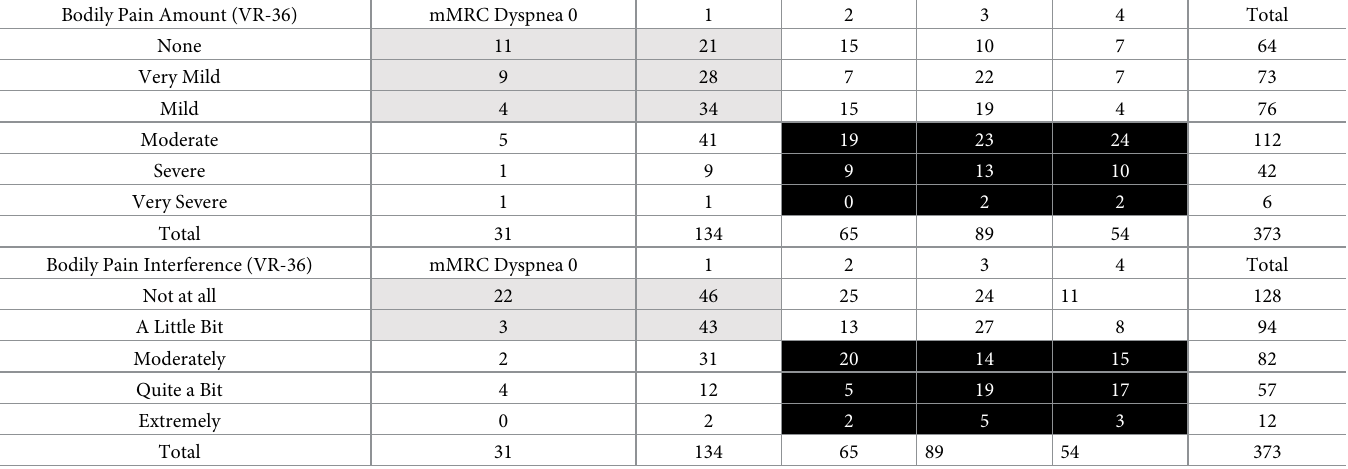
severe pain and a mMRC dyspnea score of 2 or greater (shaded black). Sixteen persons (29%) had no to very mild pain and no to very little dyspnea (shaded gray). Similar proportions (white 53%, black 13%, and gray 34%) are seen for pain interference and dyspnea (Table 4B).